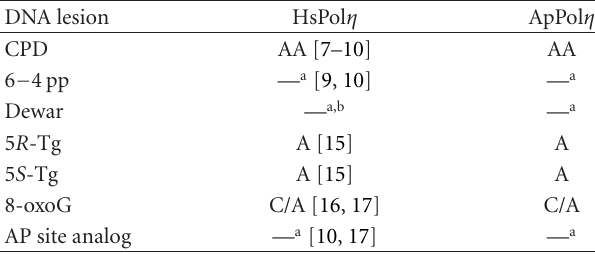
Table 1: Comparison of nucleotide incorporation into lesion- containing template-primers between HsPol η and ApPol η